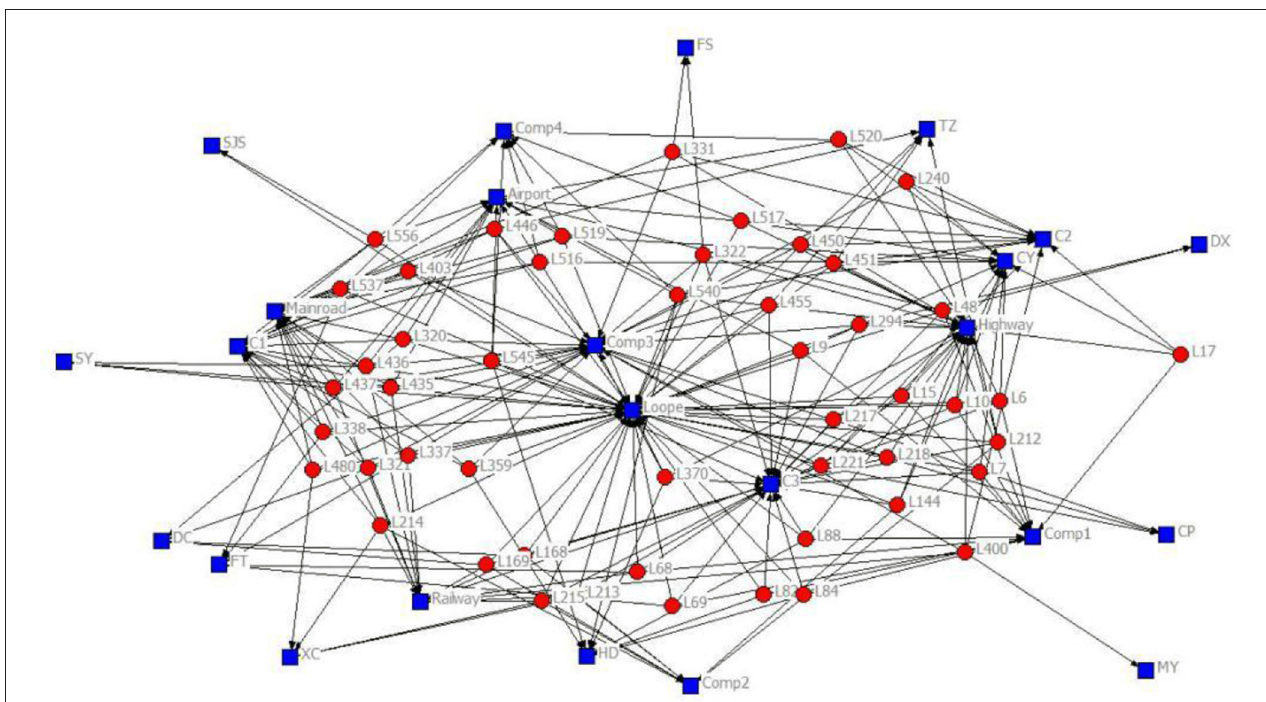
FIGURE 2 | 2-Mode Network of Distribution centers and Local Conditions in the Heuristic Solution of Case 2 (Solution = 50).